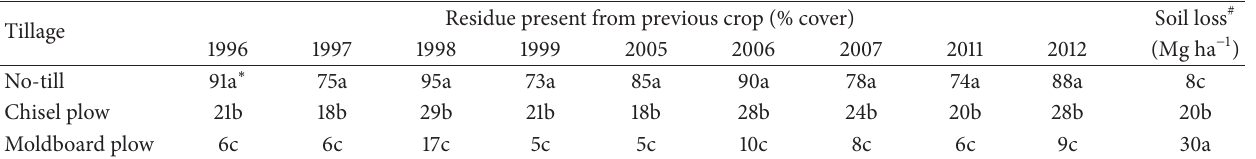
Table 1: Effect of different tillage treatments on plant residue after planting and soil loss at Dixon Springs. Odd years have soybean residue and even years have corn residue.